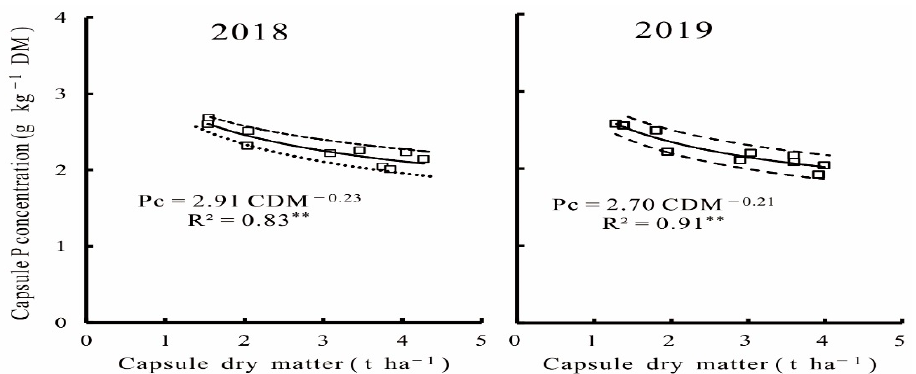
Figure 3. Changes in phosphorus concentration of the capsule for two flax cultivars at five P levels in two growing seasons. ( A ) Lonyaza 1 in 2018; ( B ) Longya 14 in 2018; ( C ) Lonyaza 1 in 2019 and ( D ) Longya 14 in 2019, respectively. The vertical bars indicate the least significant differences (LSDs) with p ≤ 0.05 among five P levels (n = 3).